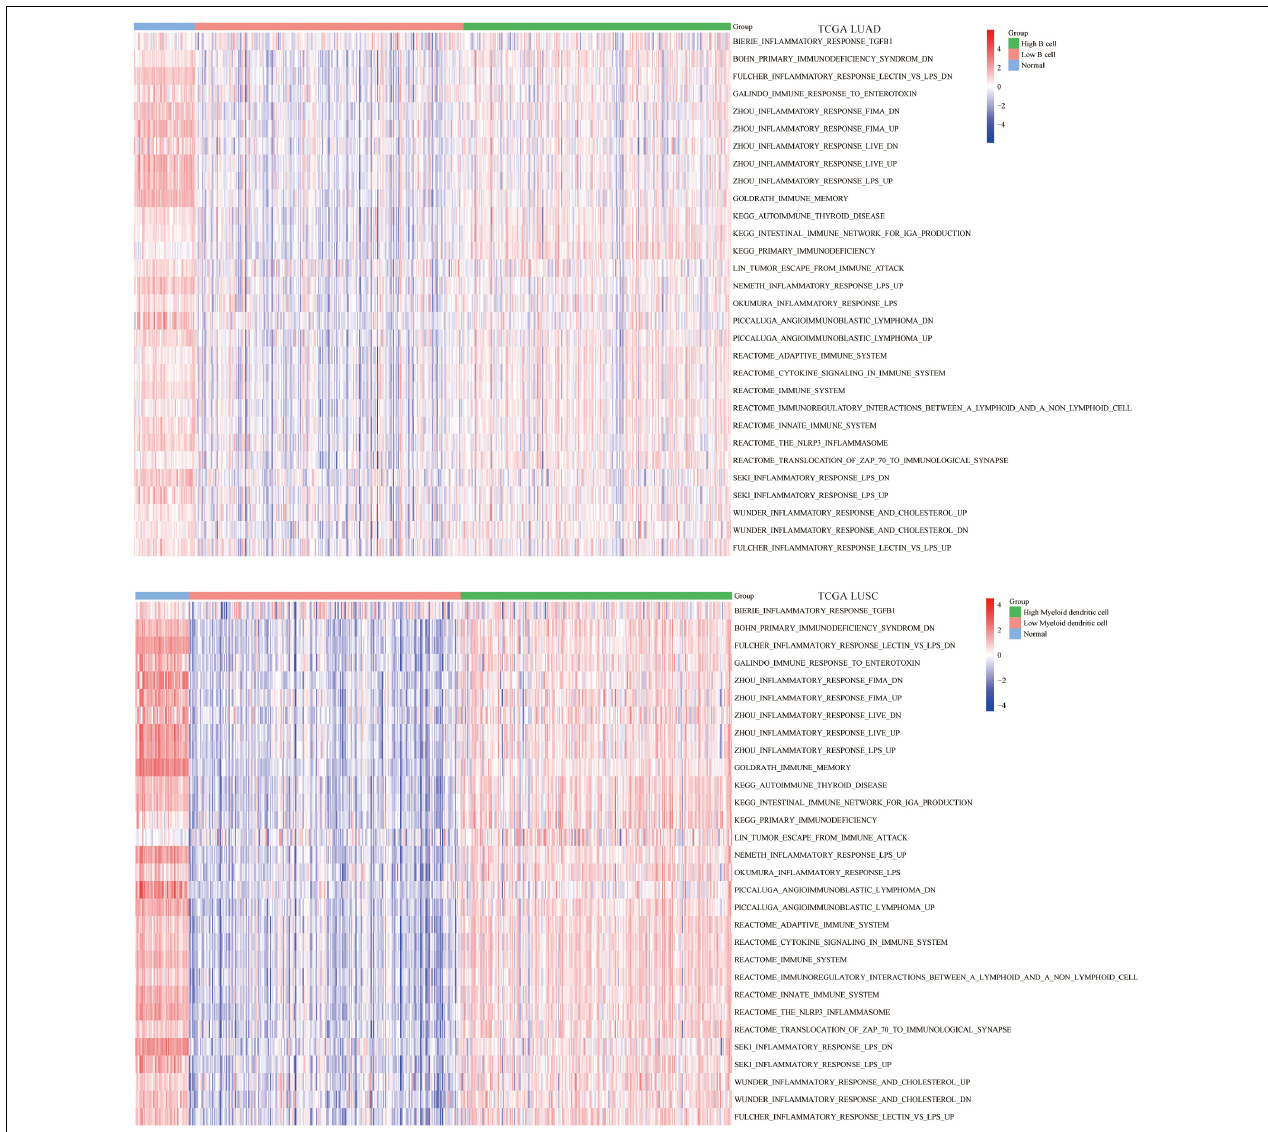
FIGURE 6 | Differences in ssGSEA scores of 30 immune-related pathways among normal, low, and high B cell/DC1 groups in lung cancer. With the increase of B cell/DC1 infiltration, most immune-related pathways were significantly